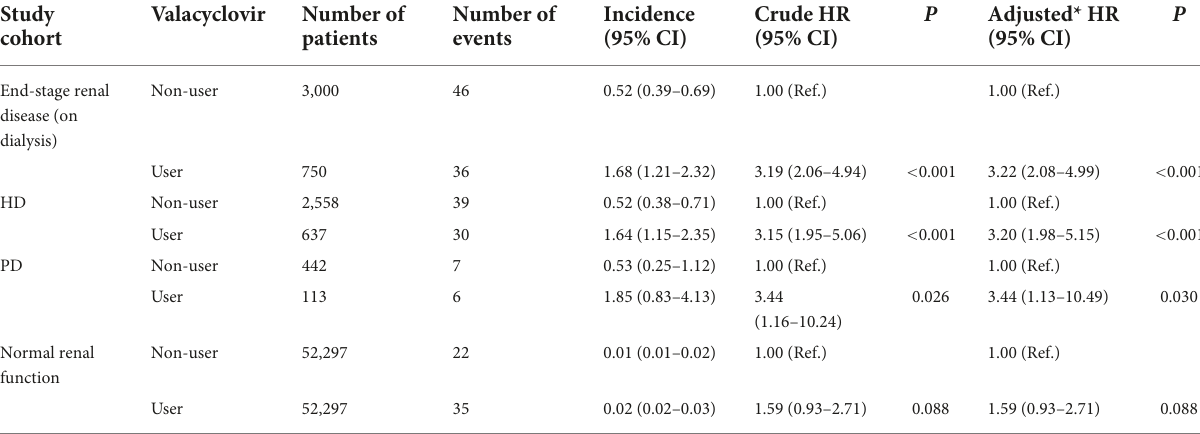
TABLE 2 Incidence (per 1,000 person-days) and risk of altered mental status among valacyclovir users and non-users over a 30-day period. Study cohort